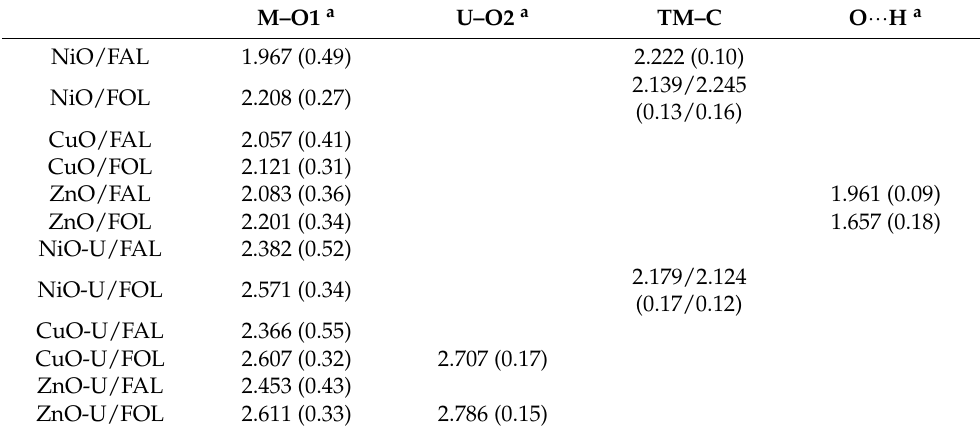
Table 1. Optimized bond lengths (Å) and bond orders (in parentheses) of Cat/FAL and Cat/FOL